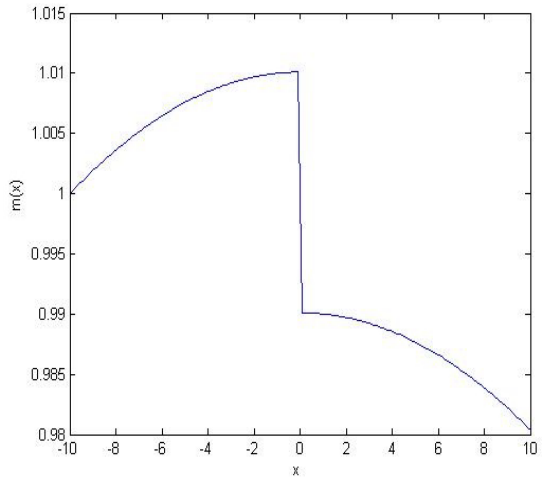
Figure 1. Variation of m ( x ) (Equation (10a)) with position for λ = 0.01.